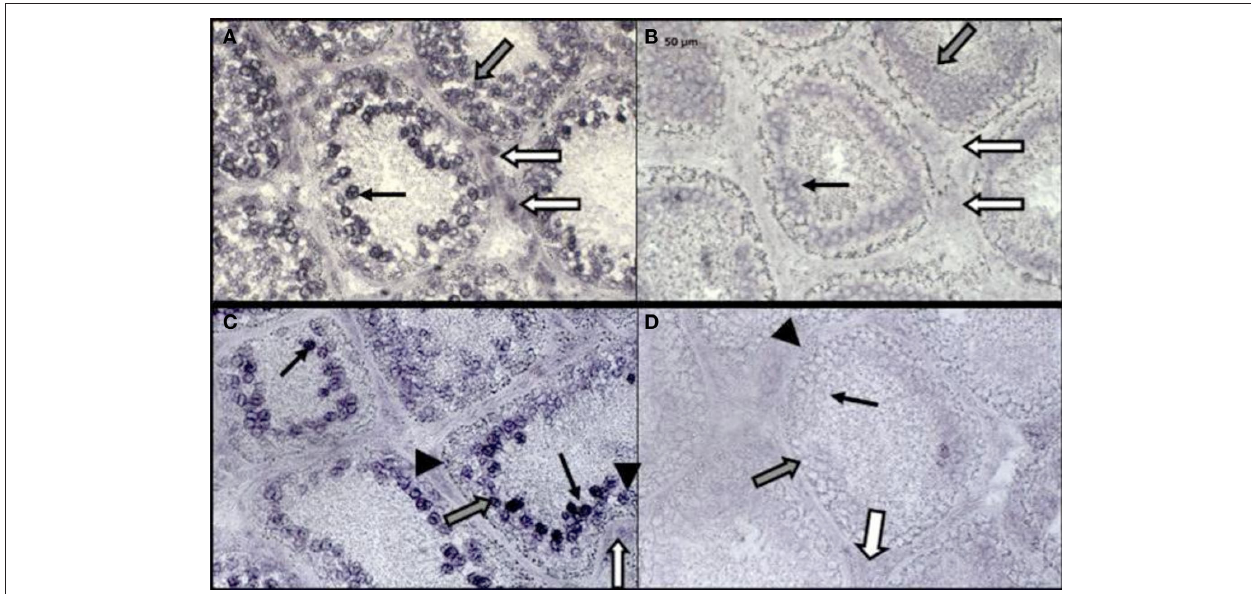
FIGuRe 3 | In situ hybridization for RF-amide related peptide (RFRP) and its receptor (OT7T022) in rhesus macaque ( Macaca mulatta ) testis. RFRP antisense probe labels mRNA in Leydig cells, spermatogonia and spermatocytes (A) . An adjacent section incubated with RFRP sense probe (control) is shown in (B) . OT7T022 antisense probe labels mRNA in Leydig